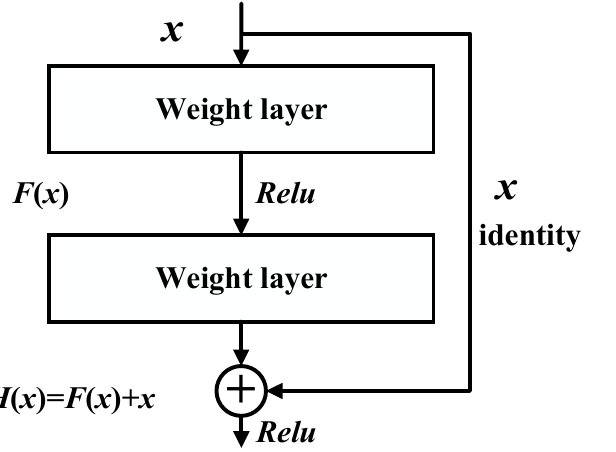
Figure 3. Residual block structure.